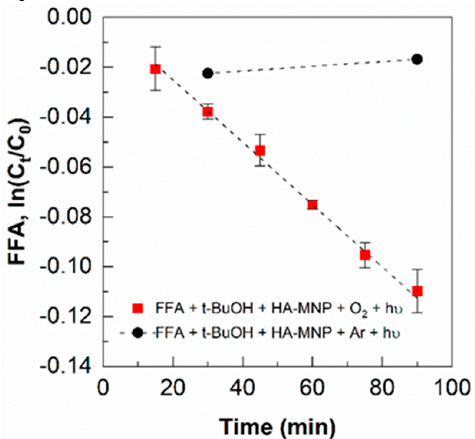
Figure 4. Determination of singlet oxygen generation based on the degradation of FFA, under 350 nm irradiation in the presence of [HA-MNP] = 1.0 g L − 1 ; [FFA] 0 = 100 µM; [ t -BuOH] = 10 mM, under oxygen-saturated ( ■ ) and argon-saturated control experiments ( ● ); error bars represent the standard deviation of triplicate measurements.